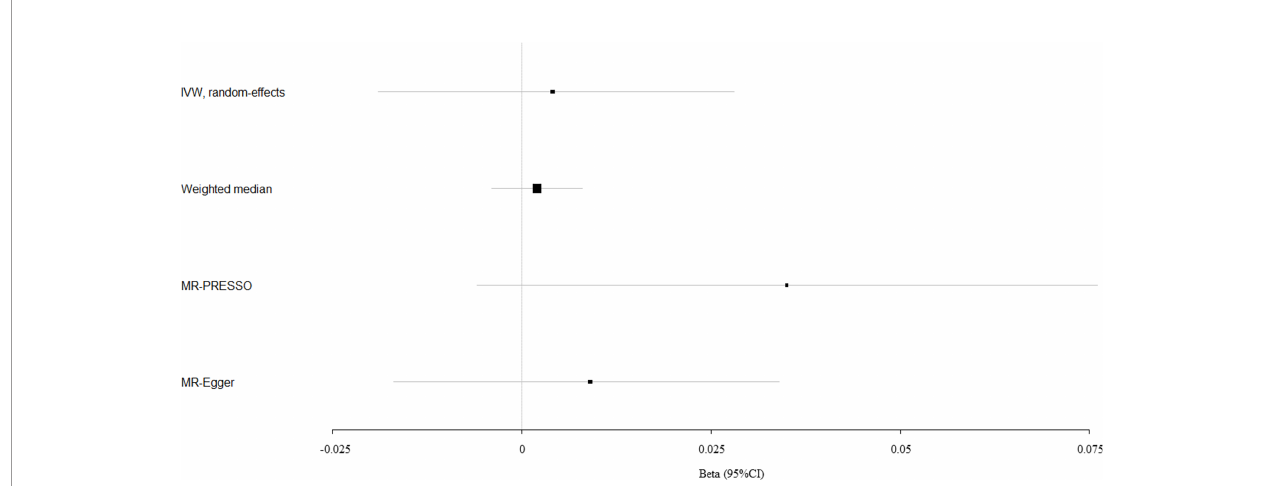
FIGURE 1 | Mendelian randomization analysis for the association between circulating bilirubin levels and